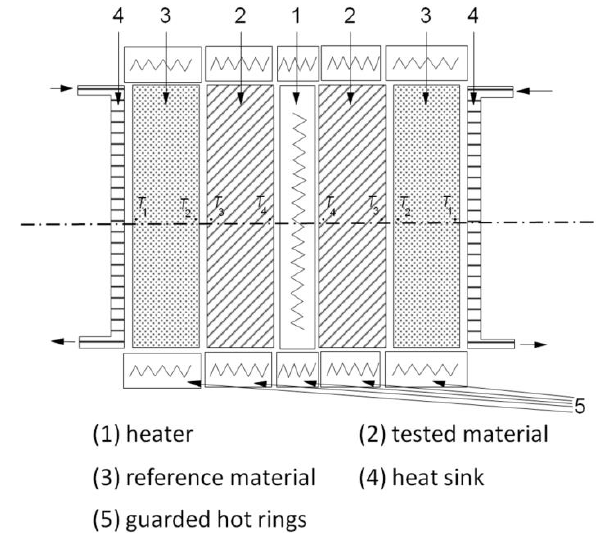
Figure 3. Sketch of the guarded hot ring with a reference material.